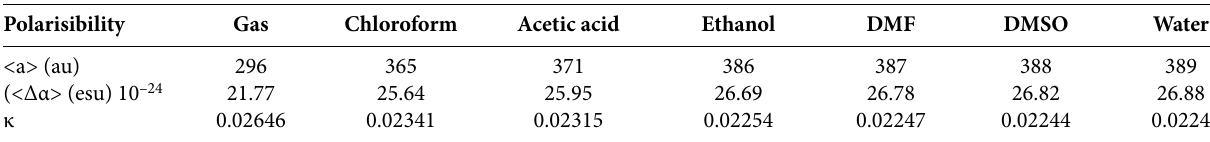
Table 2. Polarizability ( 〈 α 〉 ), anisotropic polarizability (∆α), Kappa (κ) of the optimized Iopamidol molecule in the gas phase and different solvents. Polarisibility Gas Chloroform